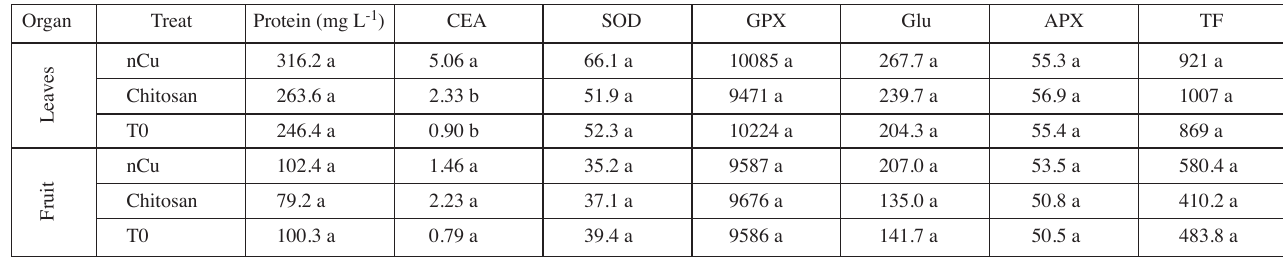
Tab. 4: Antioxidant compounds in tomato leave and fruits treated with nCu-chitosan hydrogel at a concentration of 0.006 mg nCu L -1 .